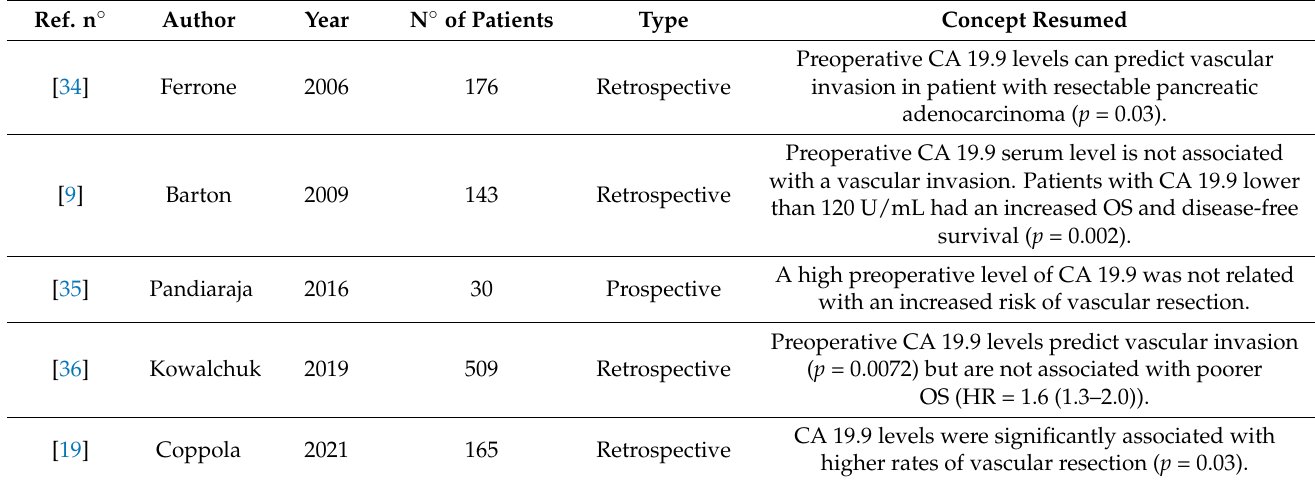
Table 3. Main characteristics and findings of studies reporting data about association between CA 19.9 levels and vascular invasion.